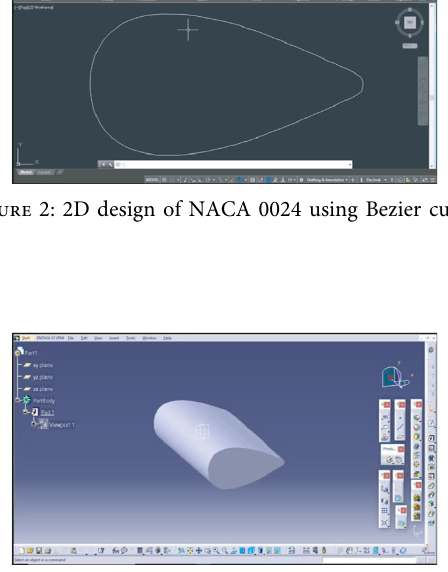
Figure 3: 3D design of NACA 0024 using Bezier